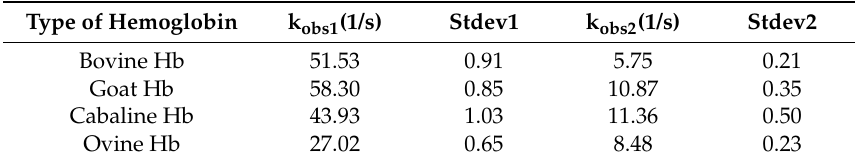
Table 3. Apparent rate constants of the reaction between different types of hemoglobin and